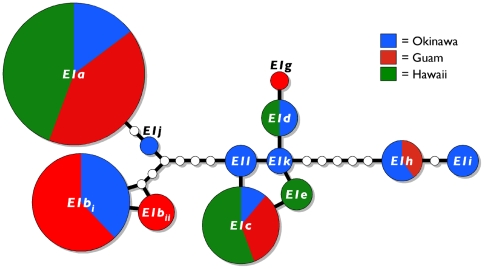
Haplotype network of alleles of conotoxin locus E1 of Conus ebraeus at Guam and Hawaii.Haplotypes are illustrated as circles; hypothetical haplotypes that were not observed are illustrated as small, empty circles. Areas of circles are proportional to frequencies of alleles; pie diagrams illustrate the allelic frequencies at each location.